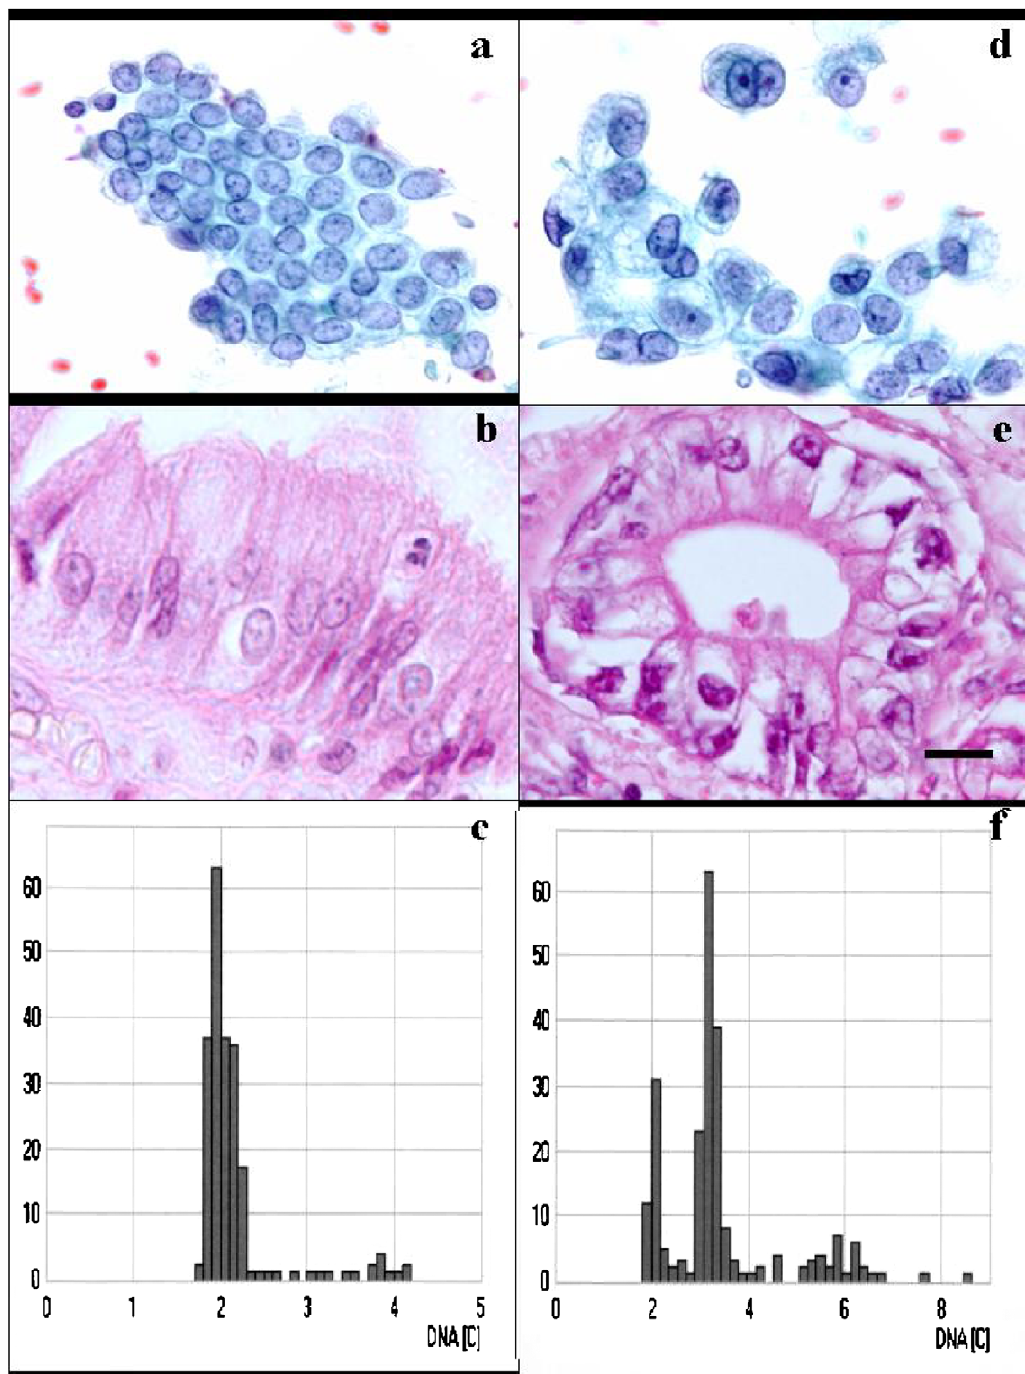
Fig. 1. Healthy biliary epithelium . (a) Papanicolaou-stained smear brushing showing benign epithelial cells. (Original magnification, × 60). (b) Hematoxylin and eosin stained section showing healthy epithelium. (Original magnification, × 60). (c) Corresponding DNA histogram shows a diploid pattern. Neoplastic biliary epithelium . (d) Papanicolaou-stained smear brushing showing neoplastic epithelial cells. (Original magnifi- cation, × 60). (e) Hematoxylin and eosin stained section showing neoplastic epithelium. (Original magnification, × 60). (f) Corresponding DNA histogram shows an aneuploid pattern. Scale bar in lower bottom corner represent 20 µ